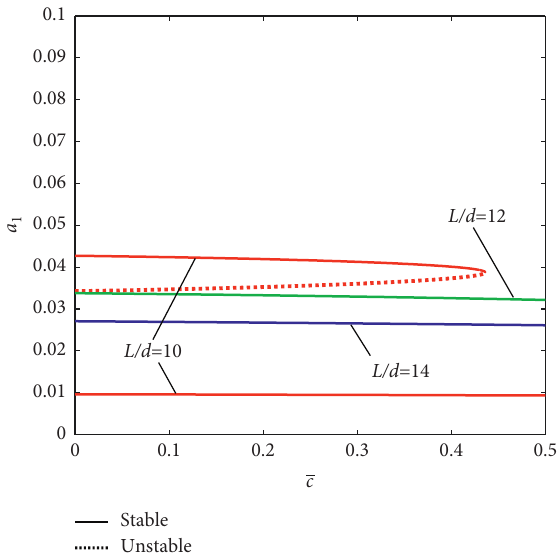
Figure 8: The effect of ply angle on frequency response curve (L/d � 10, c � 0.01, case I).